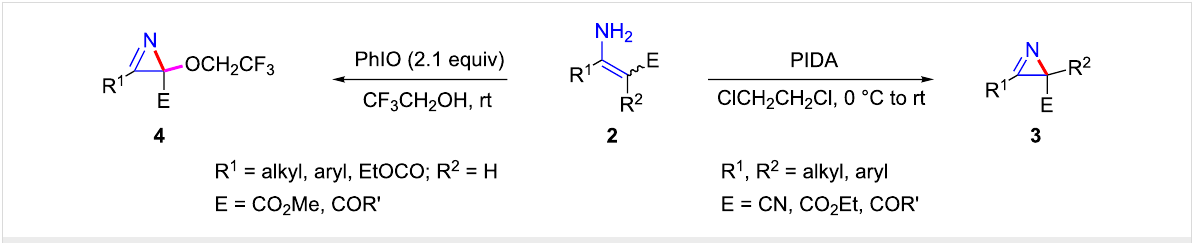
Scheme 1: Our previous hypervalent iodine-mediated synthesis of 2 H -azirine compounds.